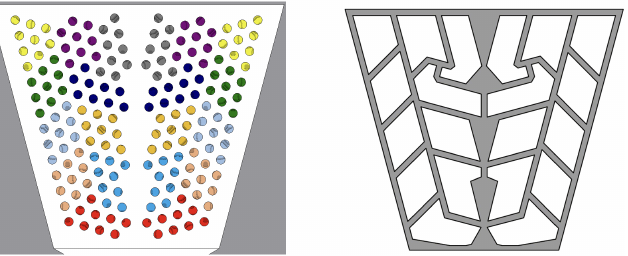
Figure 8. Strands’ positions and conductors’ shapes: ( Left ) CASE A; ( Right ) CASE B.